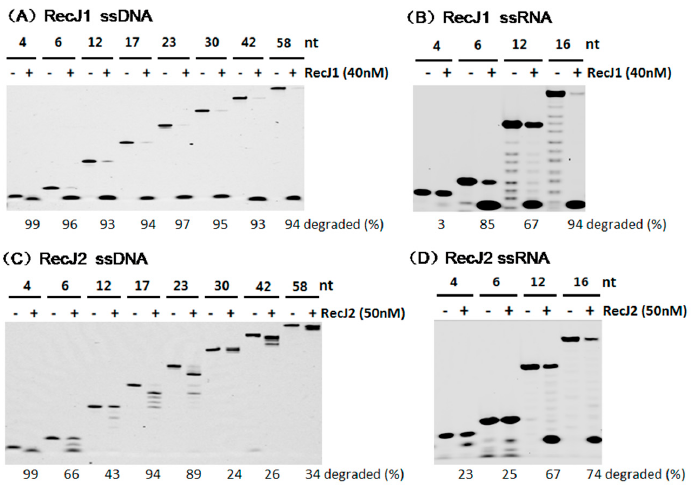
Figure 6. Substrate length preferences of MjaRecJs. Two MjaRecJs (40 nM MjaRecJ1 or 50 nM MjaRecJ2) were incubated with 200 nM 5 (cid:48) -FAM-labeled ssDNA or ssRNA with different lengths as substrates in their respective reaction buffer at 55 ◦ C for 20 min. The degraded amount of substrate was quantified at each time and listed at the bottom of the